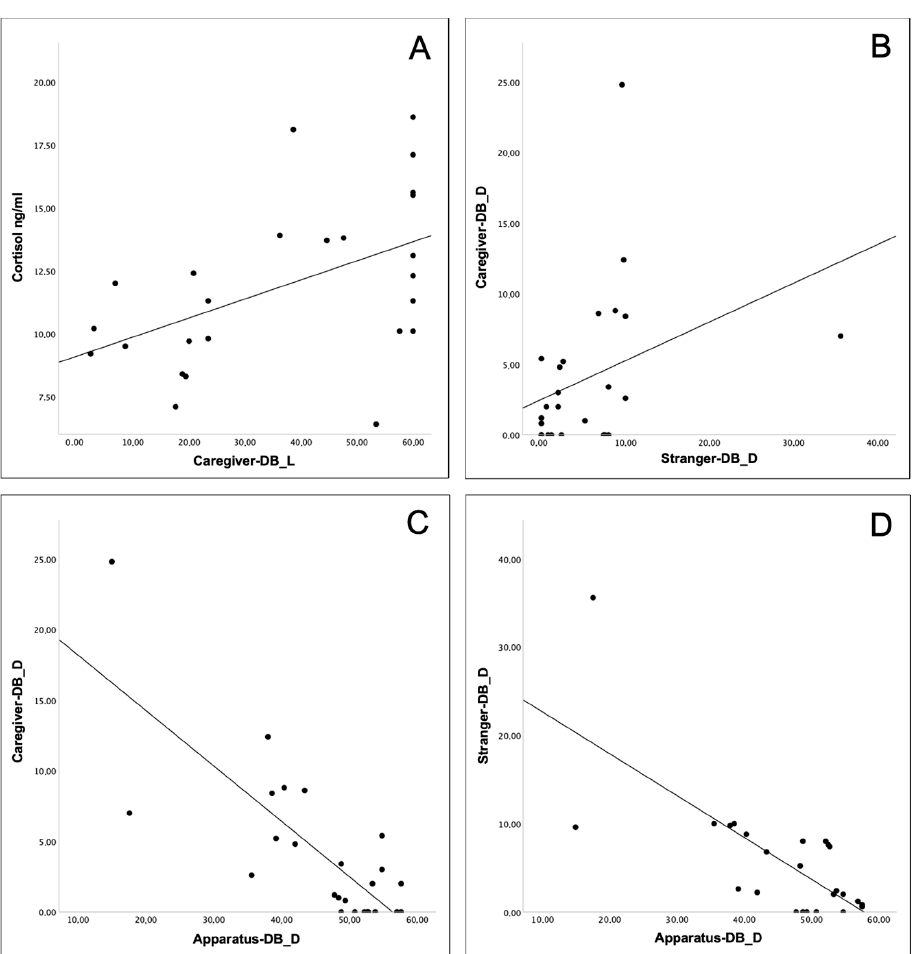
Figure 2. Spearman correlations: between cortisol and caregiver for latency ( A ); between caregiver and stranger for duration ( B ); between caregiver and apparatus ( C ), and stranger and apparatus ( D ) for duration. Sample size: 25 calves.